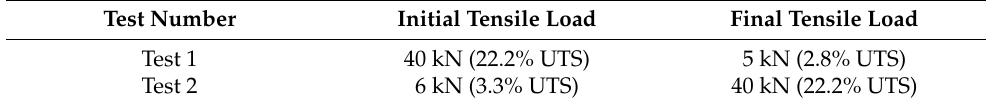
Table 3. Tests performed in the Cable Dynamics